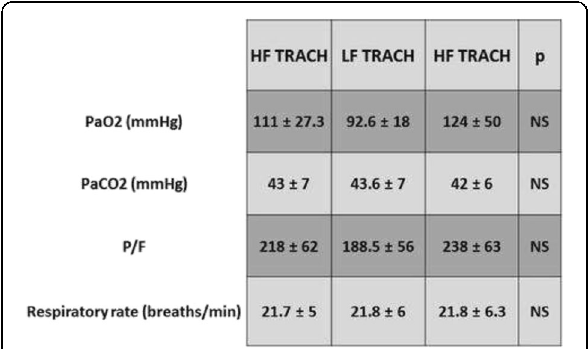
Fig. 2 (abstract 0437). Gas exchange parameters and respiratory rate trend in the patients